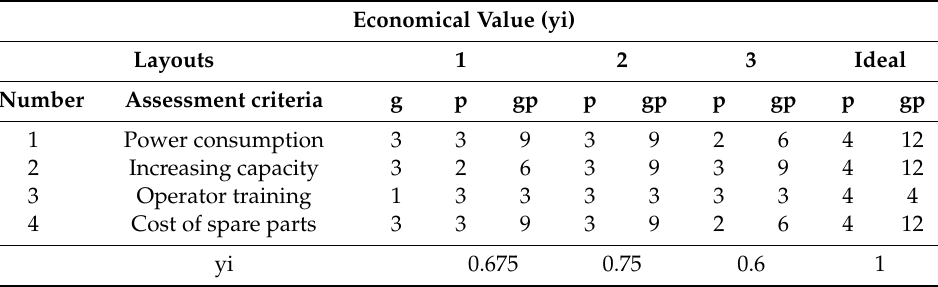
Table 3. Economical assessment of the preliminary